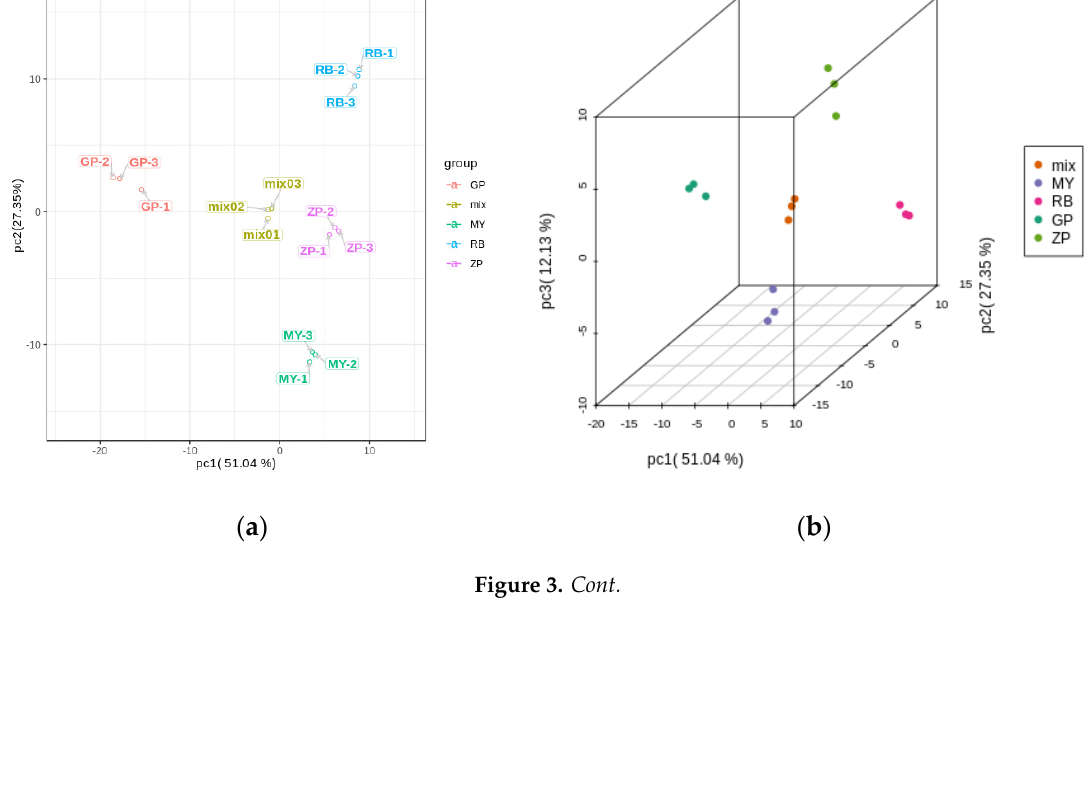
Figure 2. Total flavonoid content of the petals of the four Chaenomeles species. The lower-case letters above the histogram indicate the statistical significance at p <